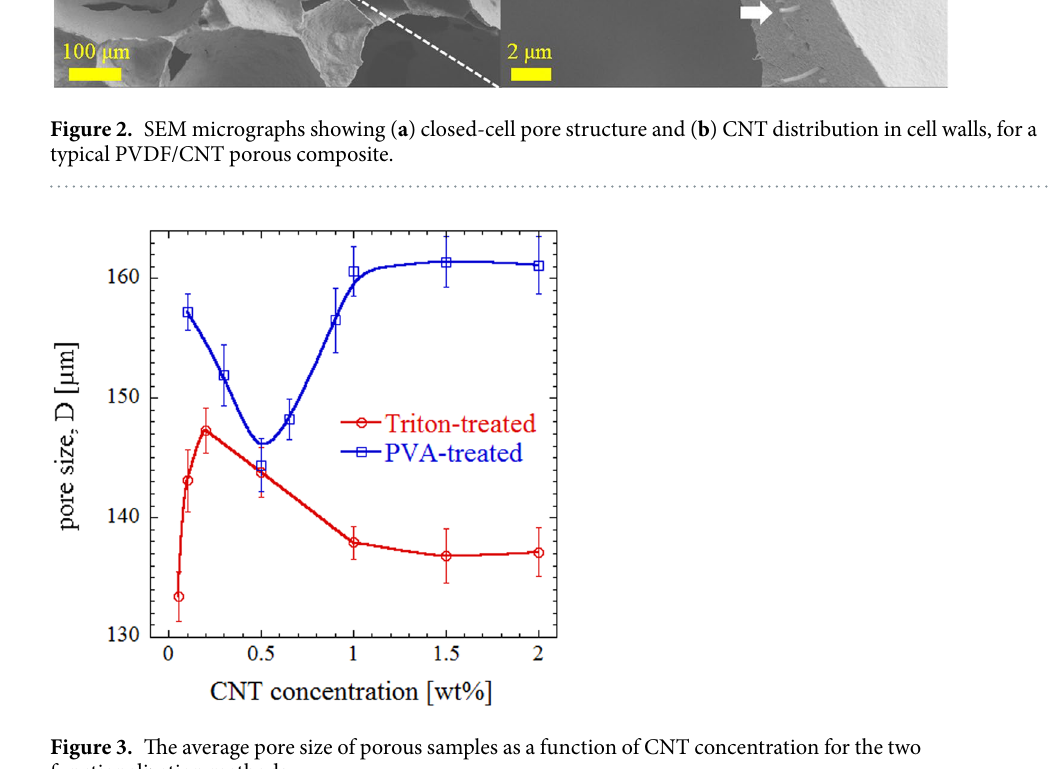
Figure 3. The average pore size of porous samples as a function of CNT concentration for the two functionalization